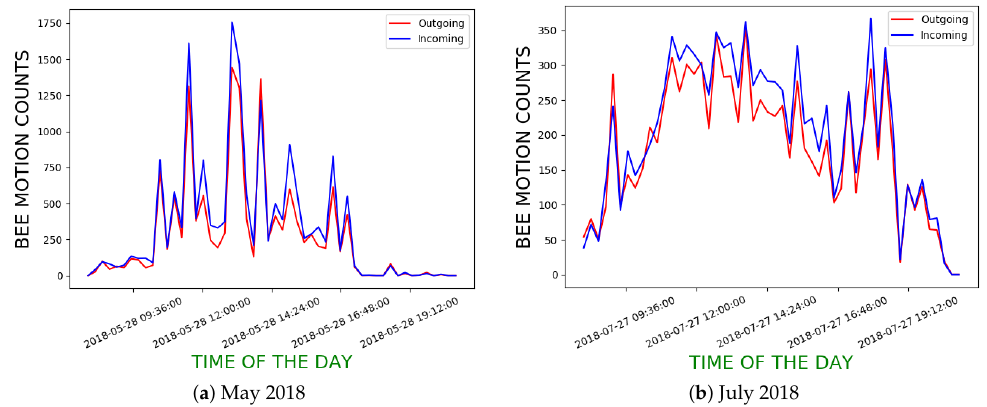
Figure 9. Incoming and outgoing bee motion count curves for two hives in Logan,